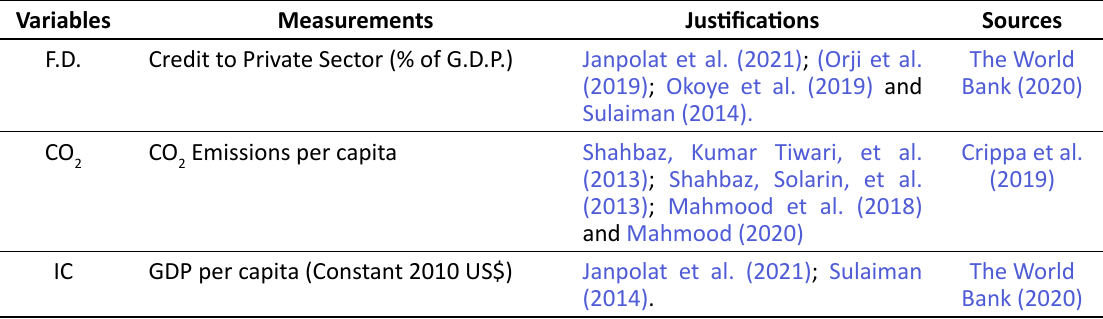
Table 1: Variables Measurement and